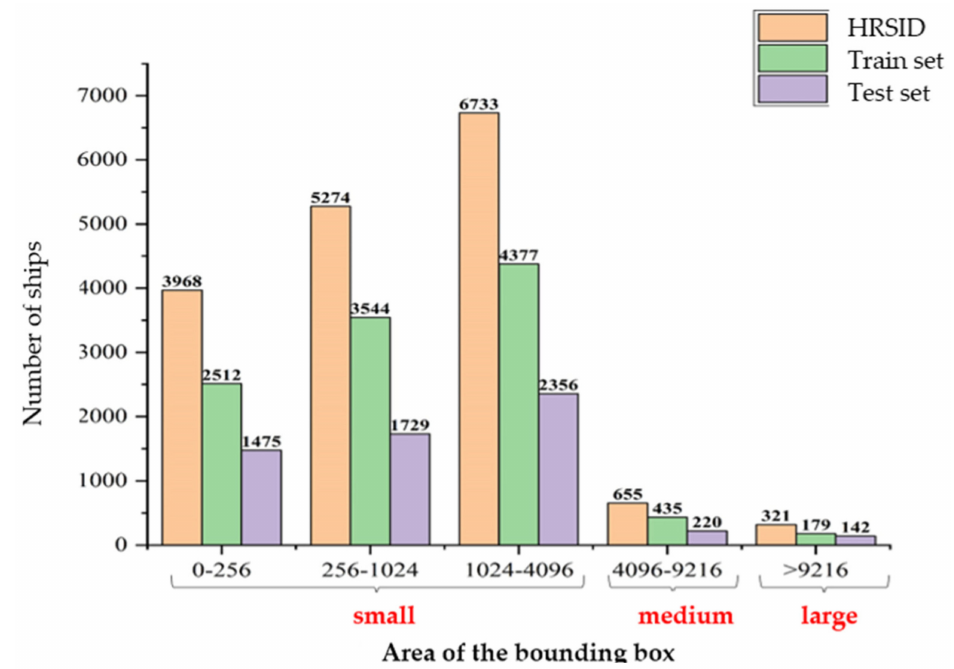
Figure 2. Statistics of the area of marine ships in the HRSRD dataset, showing that ships of a small scale are the majority of the dataset, and showing the importance of detecting and segmenting small marine